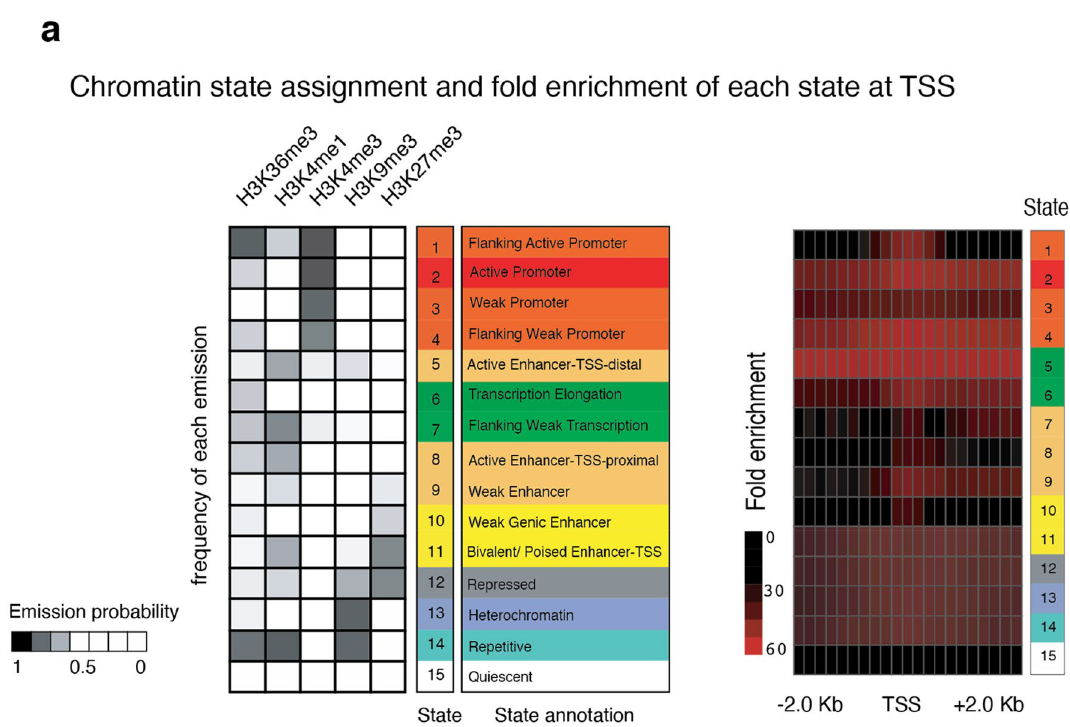
Figure 19. Analysis of chromatin state in neurons utilizing ChromHMM. ( a ) Chromatin state analysis : The right heatmap represents an enrichment of promoter-associated state at annotated TSS regions. The left plot shows enrichment of histone signal (ENCODE data from H9 derived neurons) for each annotated state as indicated by the emission probability